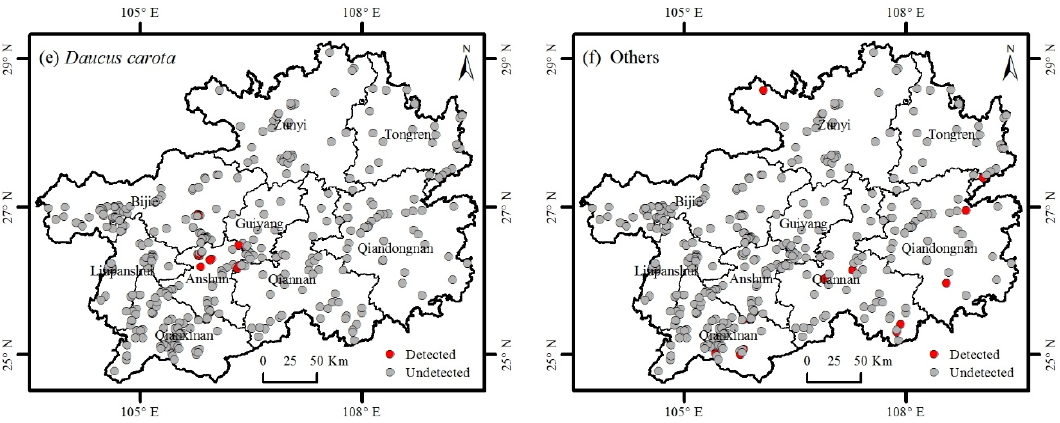
Figure 3. Distribution of seriously invasive plants (Level 2). Red and grey dots indicate detected and undetected invasive species, respectively.